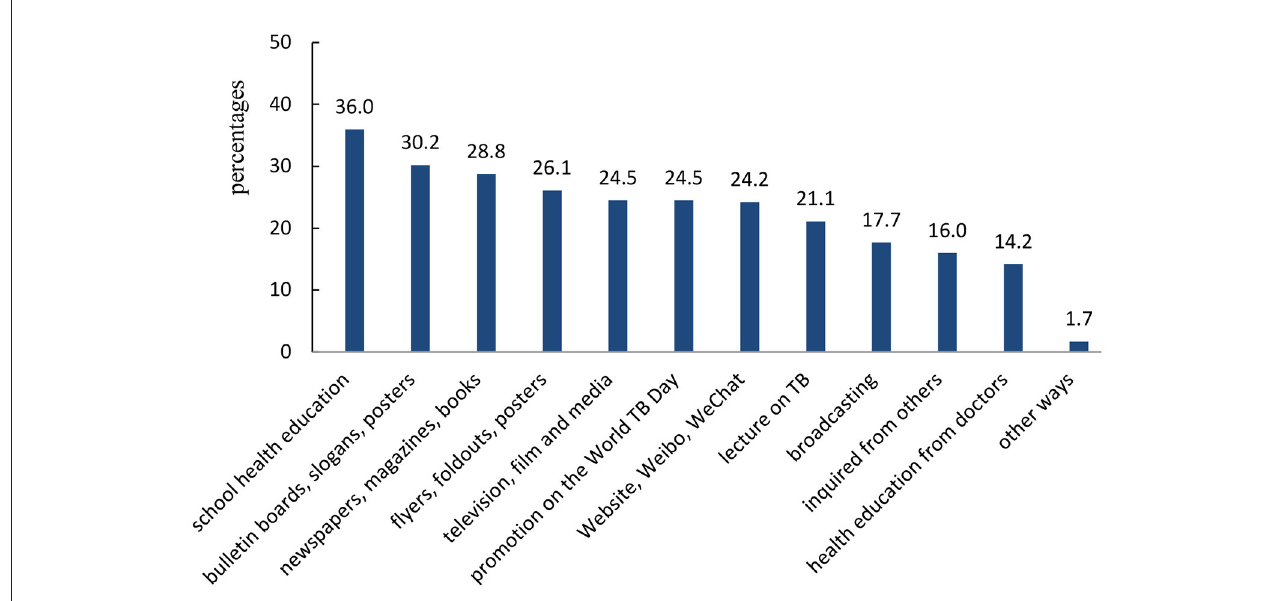
FIGURE 1 | The ways of obtaining the knowledge of TB.